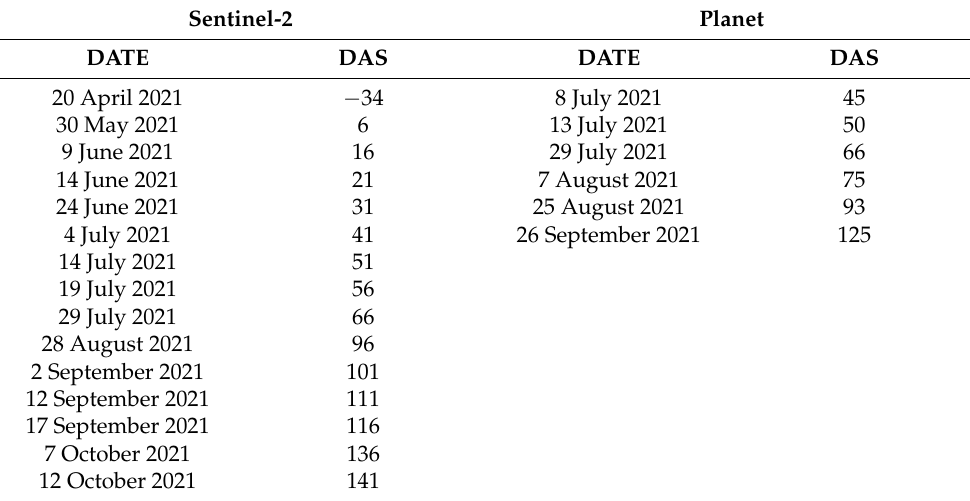
Table 1. Dates studied for each satellite, with DAS standing for days after sowing. Sentinel-2